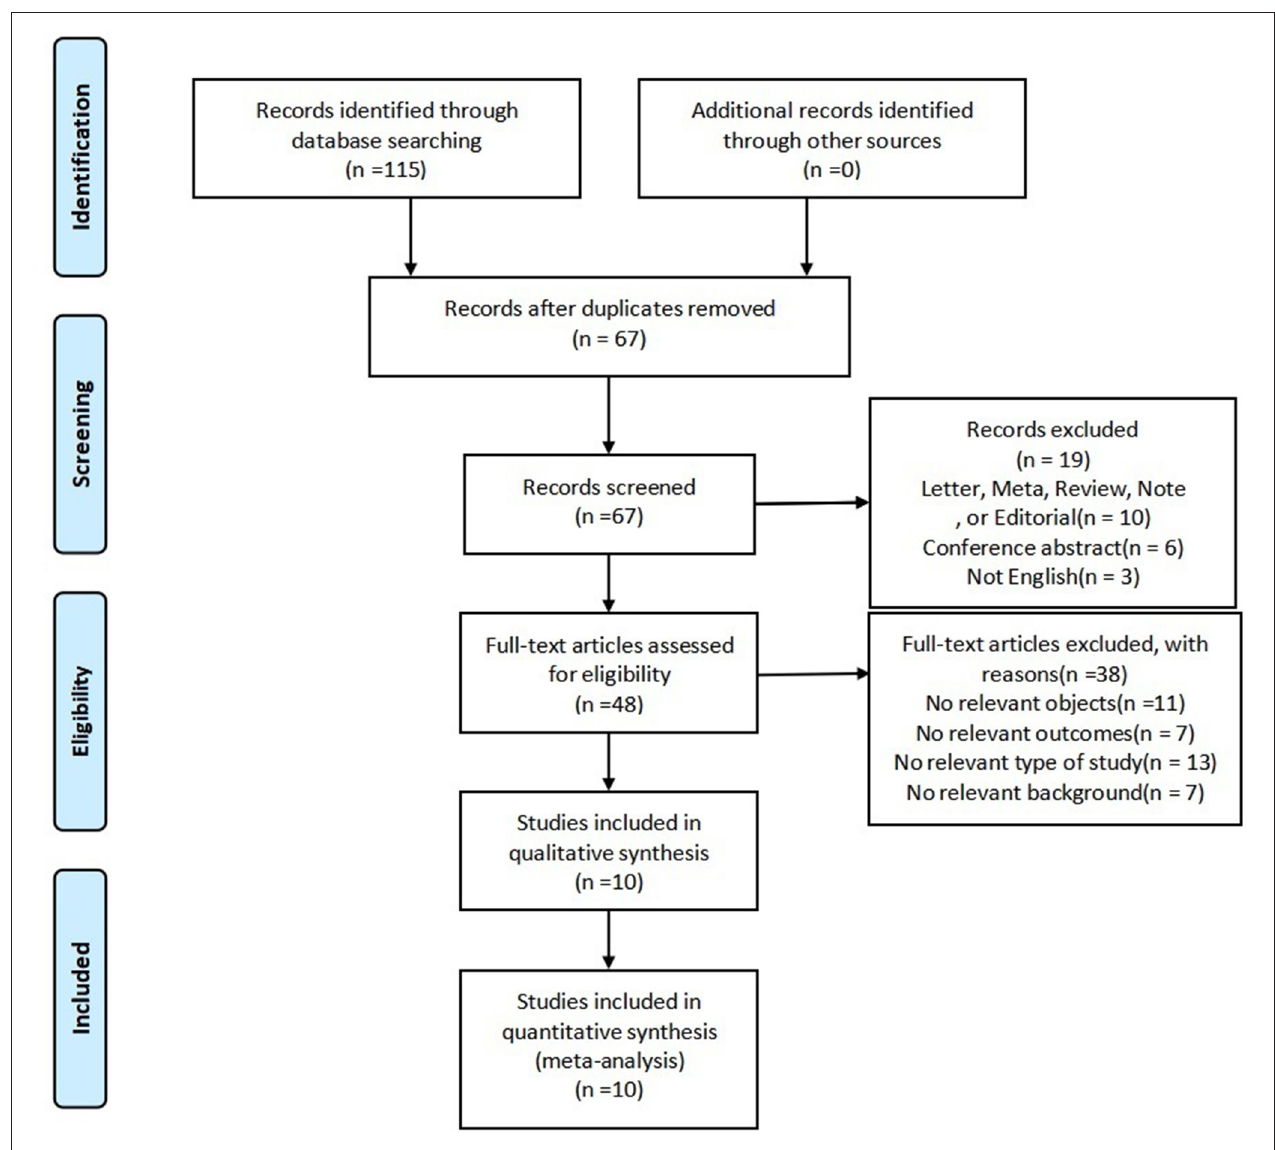
FIGURE 1 | PRISMA flow diagram of the study selection